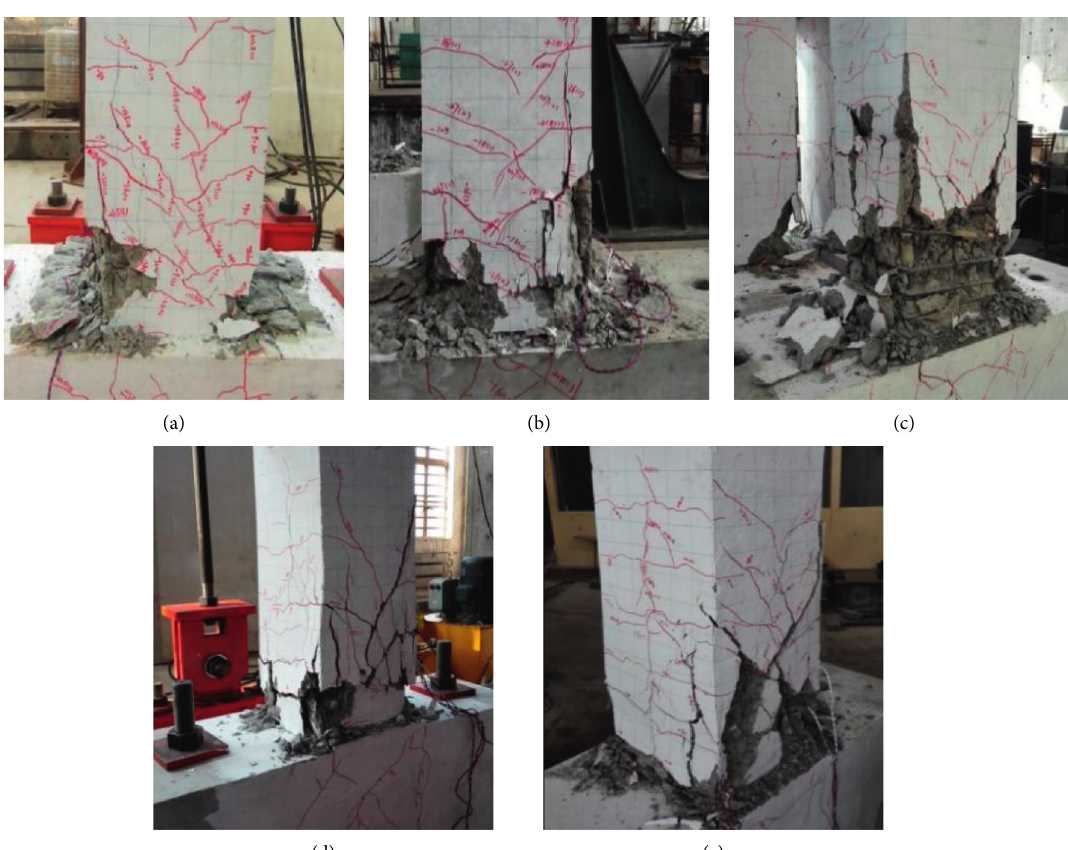
Figure 4: Failure modes of specimens. (a) PTRC-1. (b) PURC-1. (c) PURC-2. (d) PURC-3. (e) PURC-4.